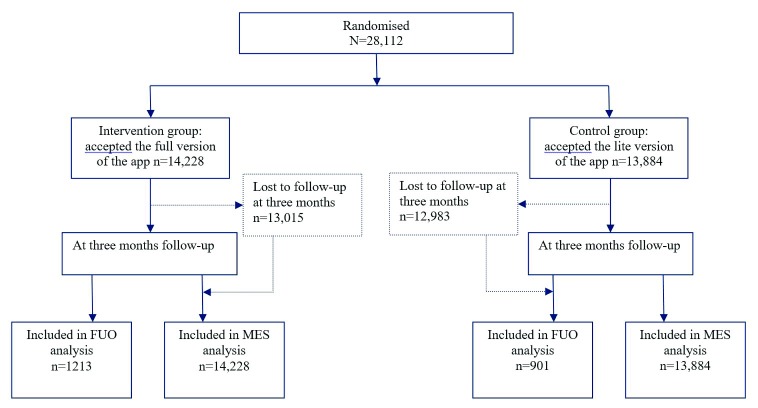
Flow of participants.